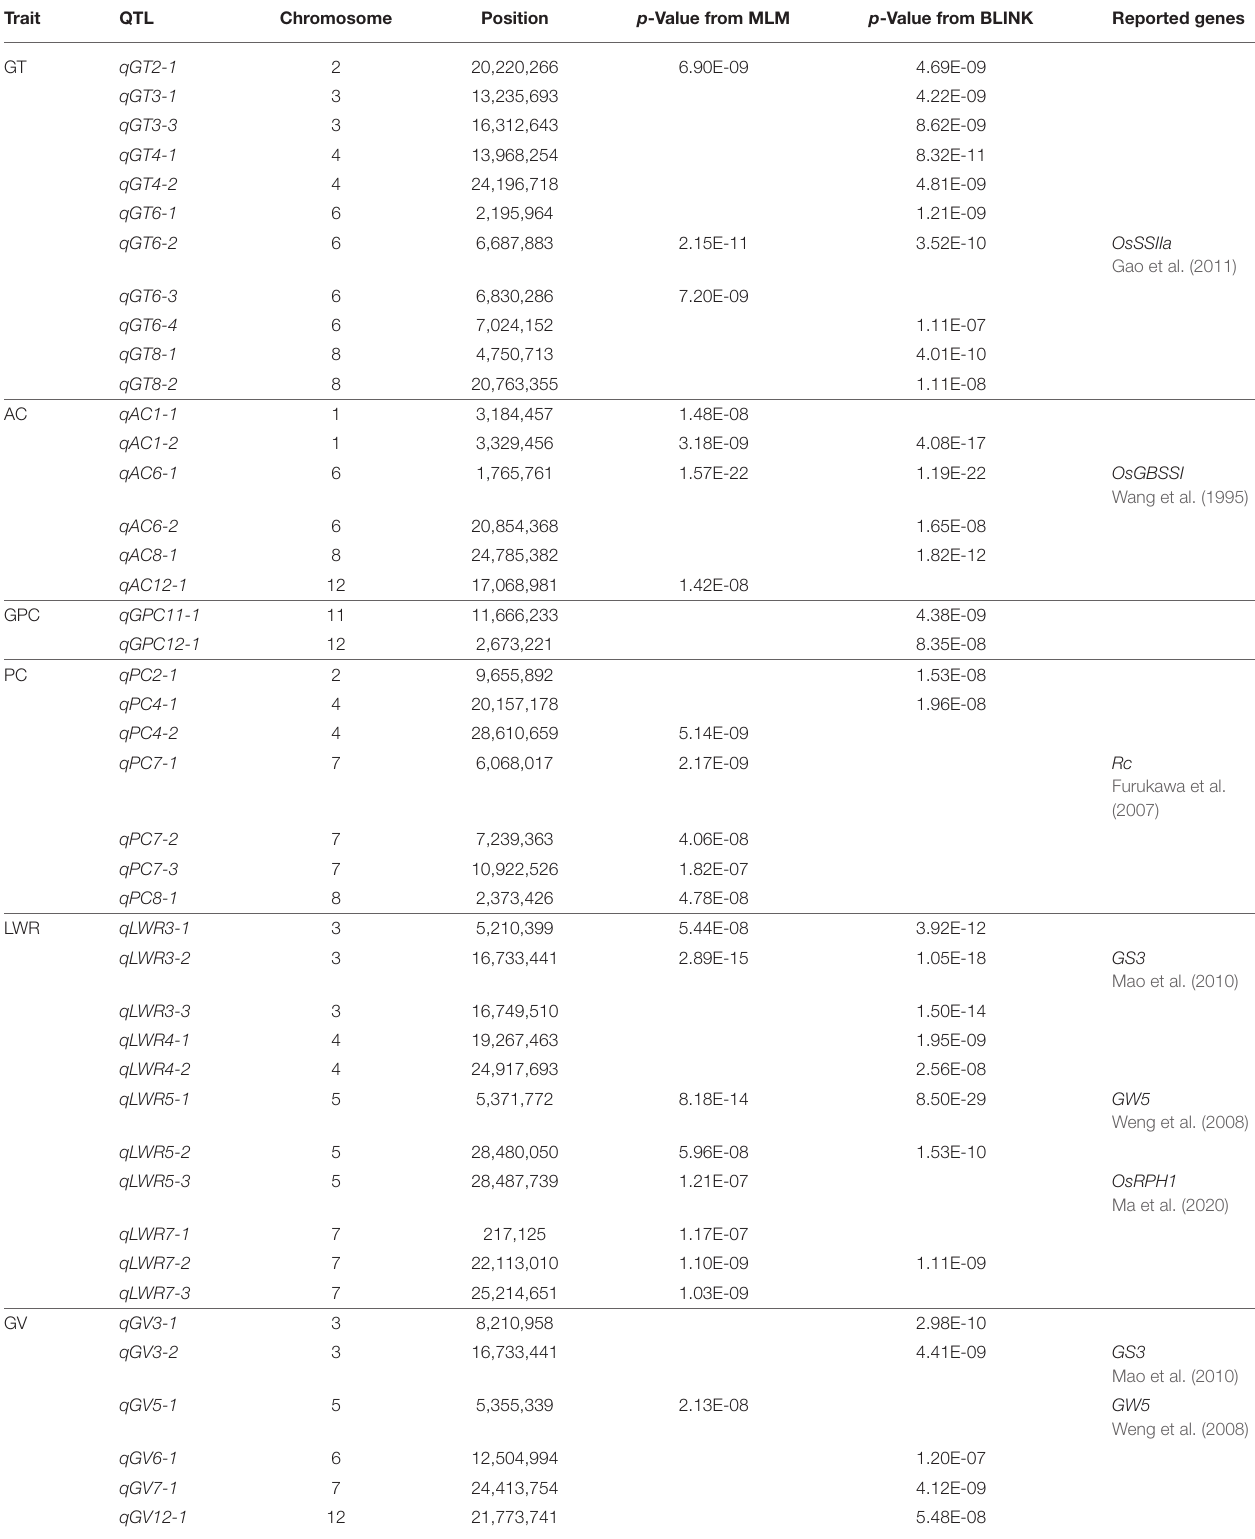
TABLE 1 | Significant SNP associated for six traits detected by genome-wide association study (GWAS) with MLM and BLINK models.